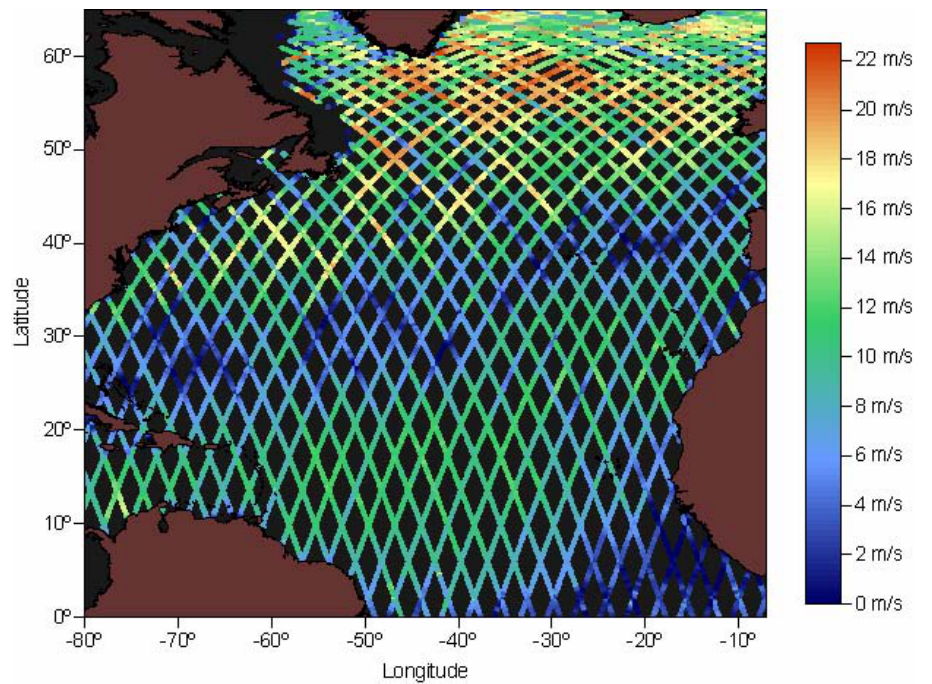
Figure 15b. Wind speed for cycle 273 (February